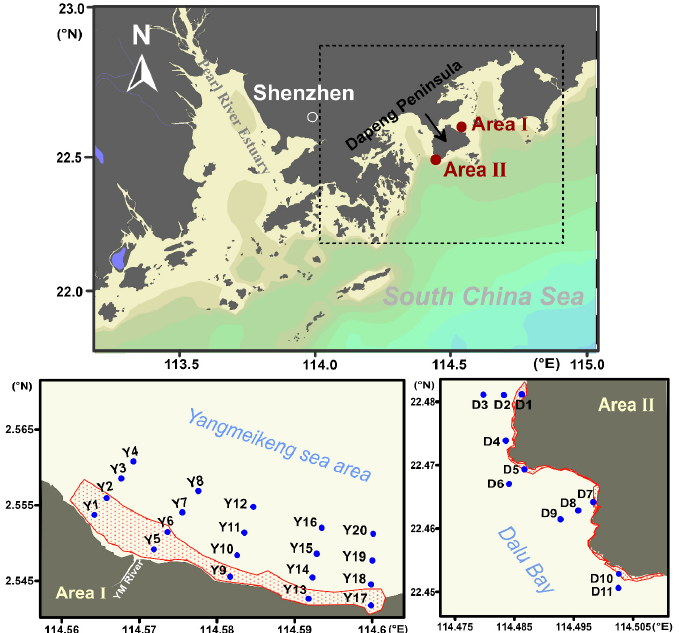
Figure 1. Sampling sites in the coastal waters near Dapeng Peninsula, South China Sea. Areas I and II are located in the Yangmeikeng sea area (Area I) and Dalu Bay (Area Ⅱ ), respectively. YM River represents the Yangmei River. The red area in the figure indicates the coral reef area.